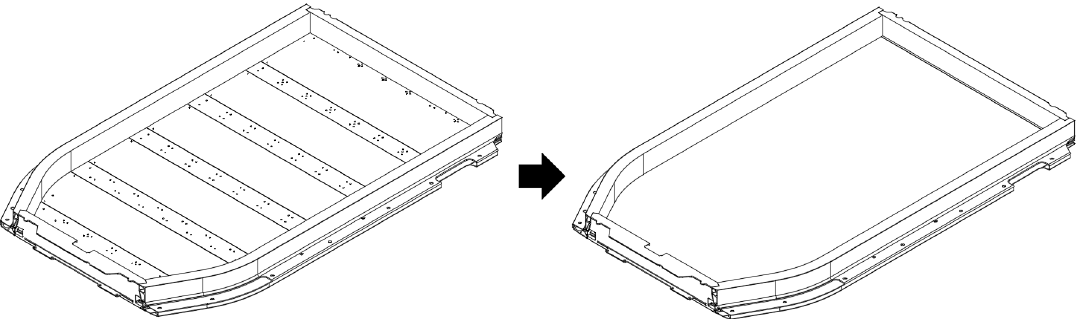
Figure 13. Simplify the design geometry of the full-frame structure.